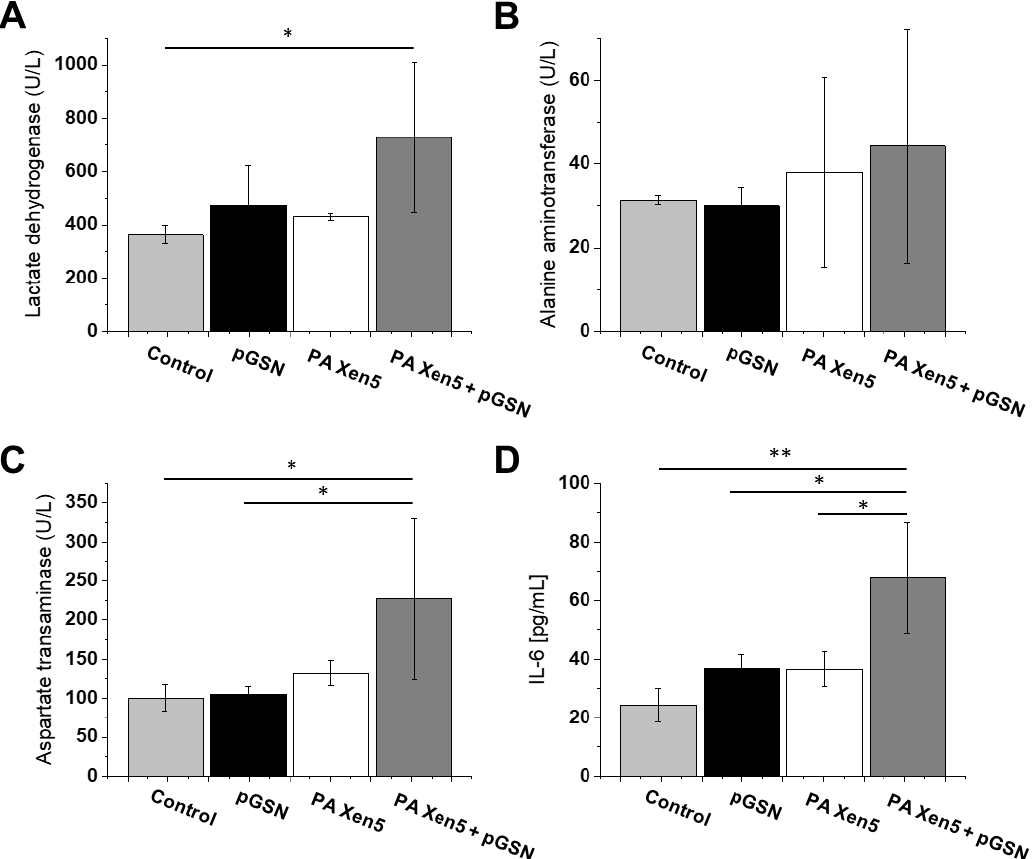
Figure 5. Blood plasma levels of LDH ( A ), ALT ( B ), AST ( C ) and IL-6 ( D ) recorded in blood samples collected from control, healthy Cby.Cg-Foxn1nu/cmdb mice (light grey columns; group 3, n = 5), healthy, pGSN-injected mice (black columns; group 4, n = 5), PA Xen 5-infected mice (white columns; group 5, n = 5) and pGSN-treated mice (dark grey columns; group 6, n = 5). At the start of the experiment mice were injected intravenously with sterile saline (group 3 and 4) or PA Xen5 inoculum (group 5 and 6). Eight hours later pGSN was added (40 mg/kg) to animals from groups 4 (pGSN, black columns) and 6 (PA Xen5 + pGSN, dark grey columns). After sacrificing the animals (24 h after injection of pGSN), blood was collected and tested for indicated markers. Results are presented as mean value ± SD. * and ** indicate statistical significance ( p < 0.05 and p < 0.01, respectively; assessed using one-way ANOVA).